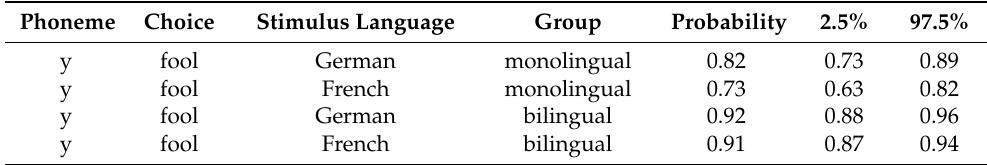
Table 6. Most probable responses given /y/ in French and German by L1 English monolinguals and L1 English